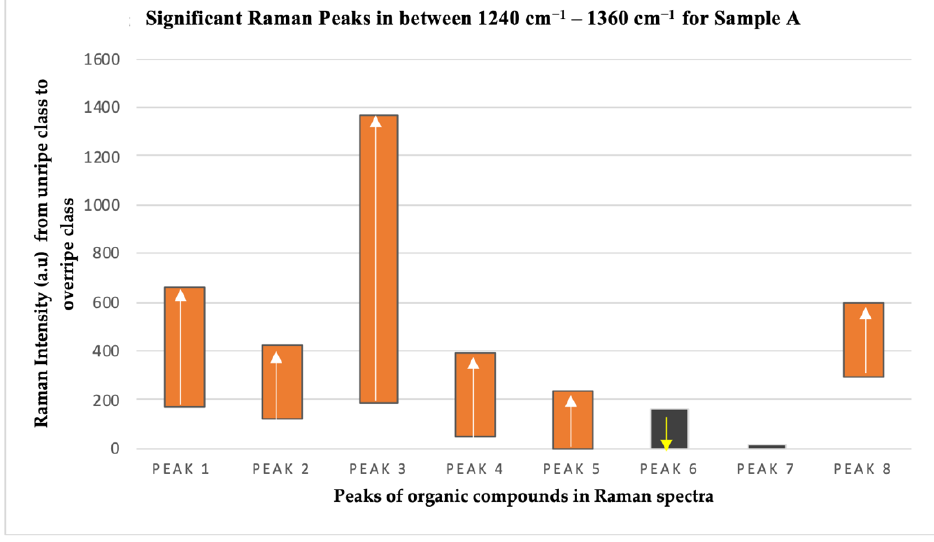
Figure 7. Trend of Raman peak intensity for the four ripeness classes in sample A.